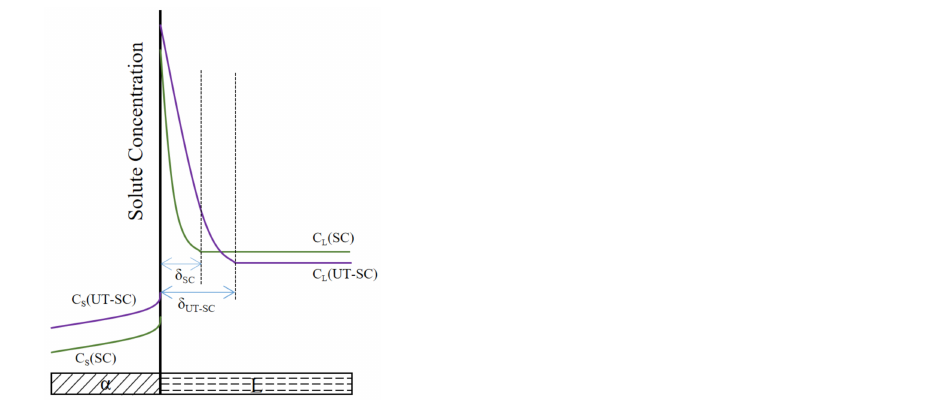
Figure 14. Solute element distribution at solid–liquid interface under SC and UT-SC